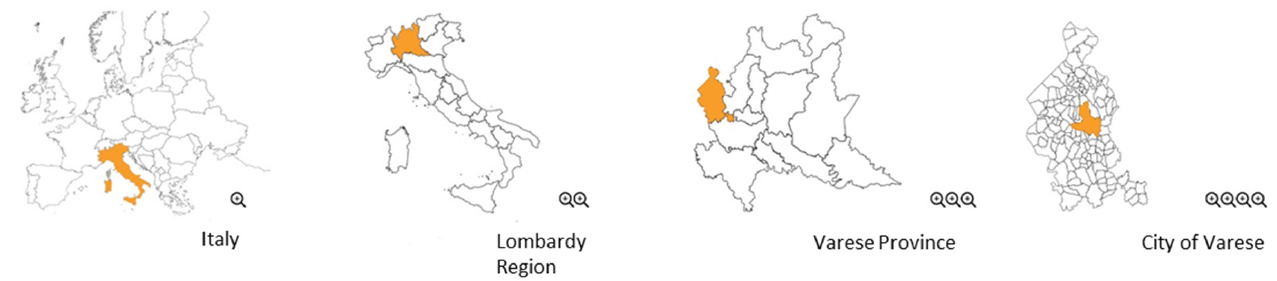
Figure 1. Location of the air-raid shelter: country, region, province, and city representations (in orange) by A. Pilo.